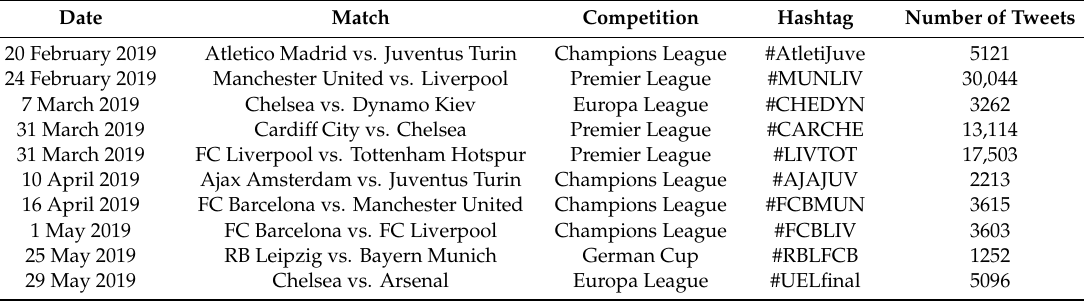
Table 2. Summary information on the